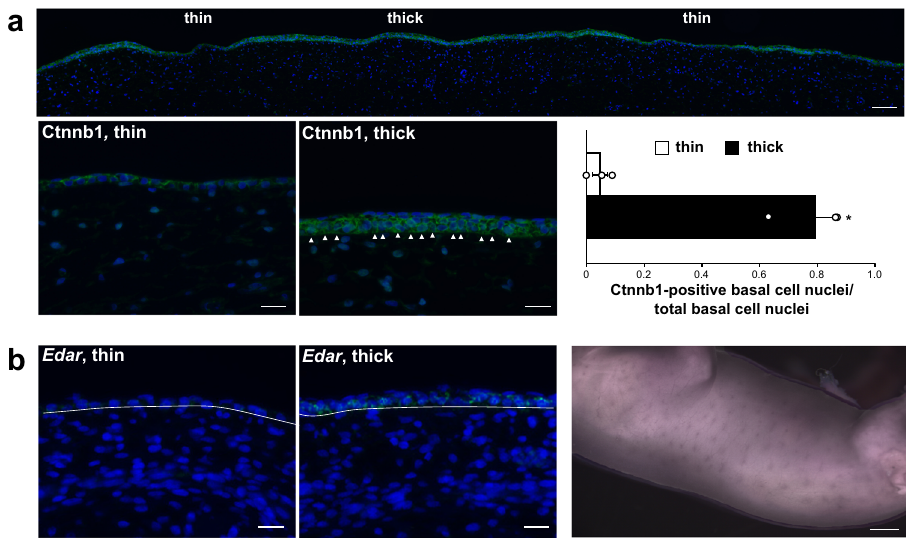
Fig. 4 Ctnnb1 immunostaining and Edar expression in embryonic cat skin. a Ctnnb1 immuno fl uorescence staining (green) in thin and thick epidermal domains from sections of Stage 16a embryonic cat skin (DAPI, blue). White arrow heads mark Ctnnb1-positive basal cell cytoplasm and/or nuclei. The bar graph shows the fraction of Ctnnb1-positive basal cells (of a total number of basal cells; mean + / − sem) in thin and thick domains ( n = 3 Stage 16a embryos, basal cells from three thick and three thin regions from each embryo were evaluated; two-tailed t -test, * P = 0.006). b Edar expression (green) in thin and thick epidermis from sections of a stage 16a embryo (similar results from Stage 16a ( n = 2) and Stage 16b ( n = 3) embryos; DAPI, blue) and Edar expression (purple) in a Stage 16b embryo ( n = 1). Scale bars: a (top), 100 μ M; a (lower left and middle), 25 μ M; b (left, middle), 25 μ M; b (right), 1.5